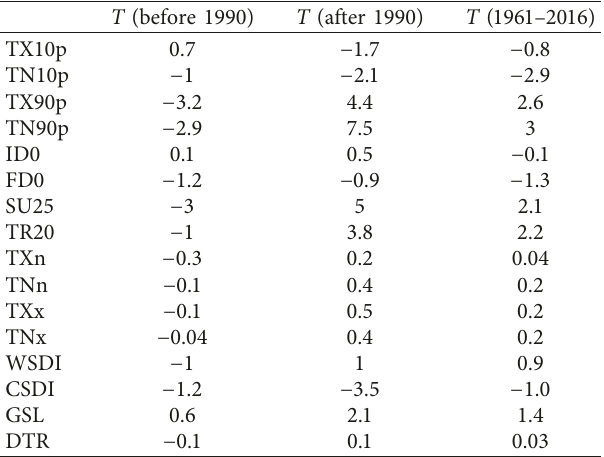
Table 5: Temporal trends of the extreme temperature indicators in the Minjiang River Basin before and after